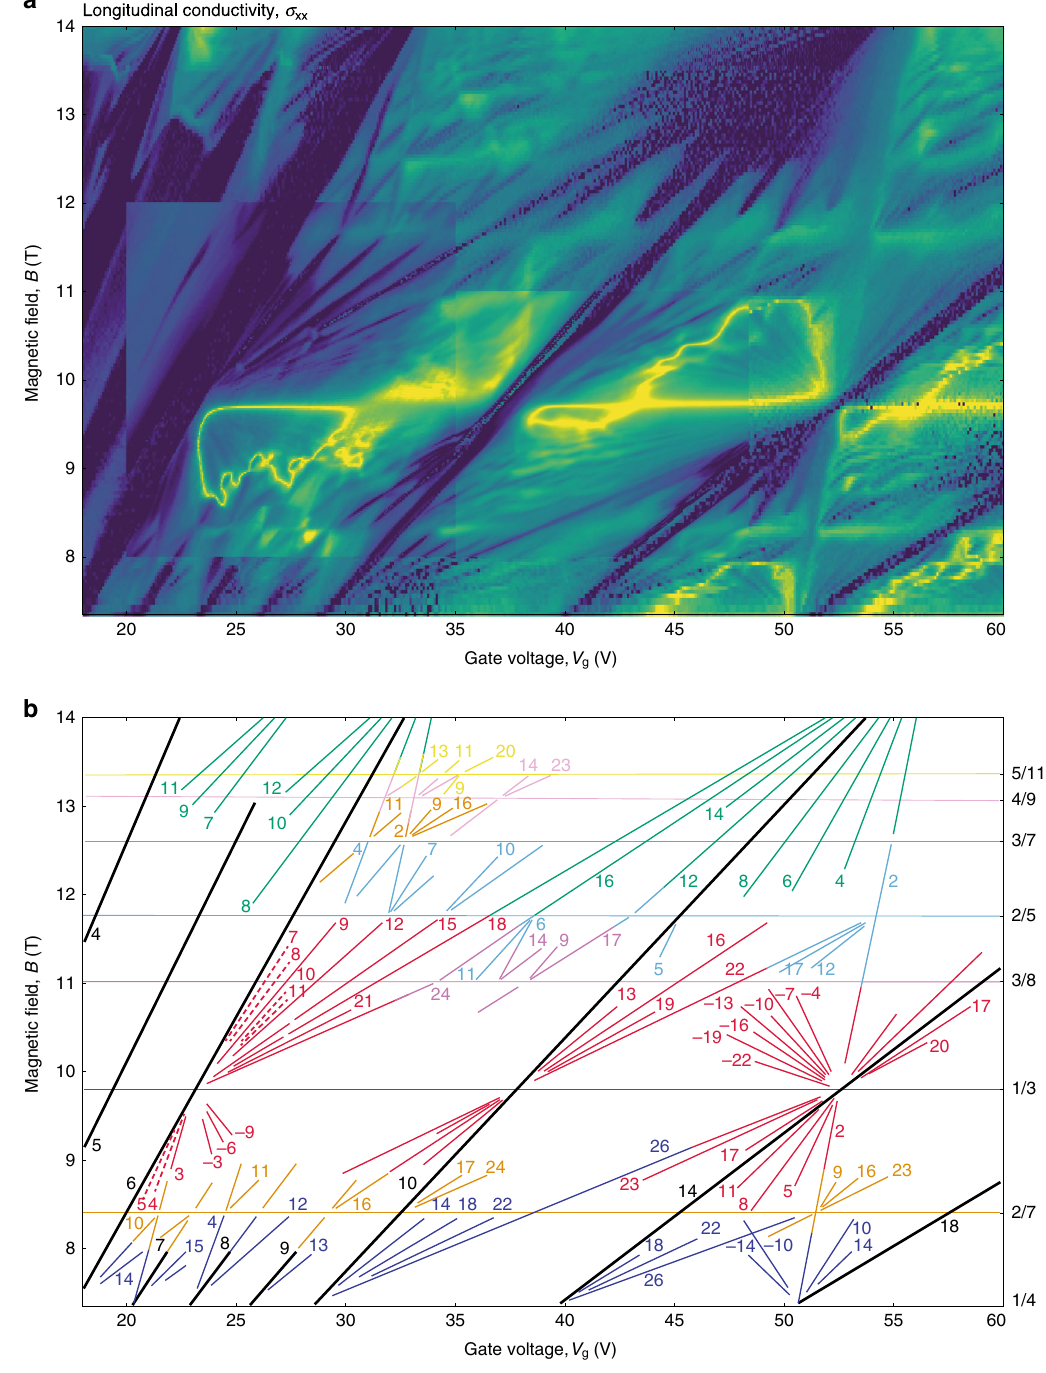
Fig. 3 Landau quantization in BZ minibands at 10 mK. a High-resolution map σ xx ( V g , B ) for the electron-doped region indicated in Fig. 1c by the white rectangle (device D1). To better resolve LLs around q = 3, B was changed in steps of 10 to 20 mT whereas data in other regions were acquired using 40 to 80 mT steps. This has resulted in the contrast discontinuities seen in the map. Log color scale: indigo (230 nS) to yellow (7.8 mS) for, the entire map. b Minima from ( a ) are shown schematically. The color-coded numbers are the fi lling factors for the corresponding LLs. Thick black lines correspond to the main sequence of LLs for graphene ’ s Dirac spectrum (spin and valley degeneracy lifted). The green, red, navy, blue, orange, magenta, pink, and yellow lines correspond to q = 2, 3, 4, 5, 7, 8, 9, and 11, respectively. Dashed red lines: minima due to lifted mini-valley fermions exhibited bending and staircase-like features. Figure 4 there can be some other electronic states that are populated in shows examples of such behavior for the case of hole doping. parallel. Because electron-electron interactions clearly play a Both bending and staircases appear away from NPs, in the signi fi cant role under the reported experimental conditions (e.g., regions close to BZ fermions ’ vHS. The observed bending towards they lift all the spectral degeneracies), it is reasonable to expect the gate-voltage axis indicates that, in addition to the visible LLs, that interactions are also involved in the described anomalies.